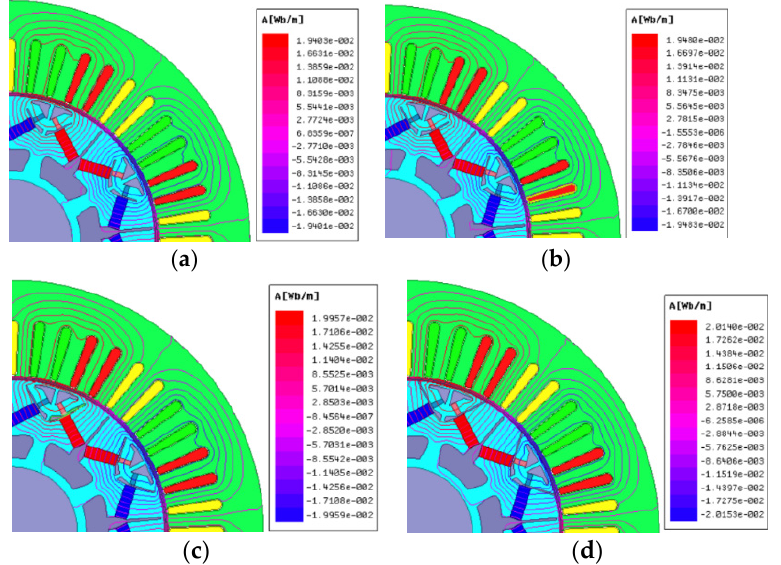
Figure 7. Distribution of magnetic lines with different lengths of magnetic barriers under the no load operation. ( a ) a = 5 mm; ( b ) a = 7 mm; ( c ) a = 10 mm; ( d ) a = 13 mm.